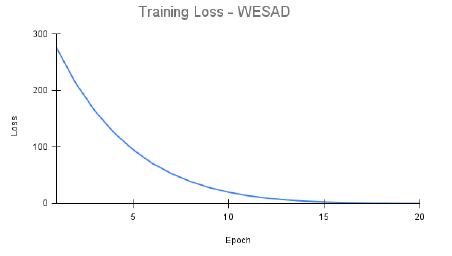
Figure 2. Training loss for T u